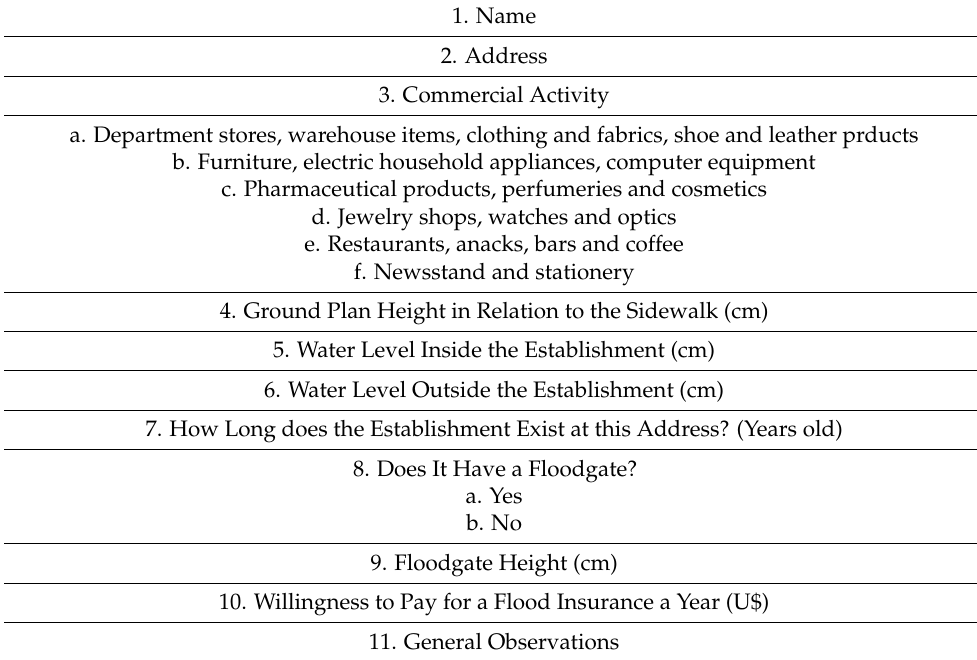
Table 1. Questionnaire related to flood impacts in the commercial center of S ã o